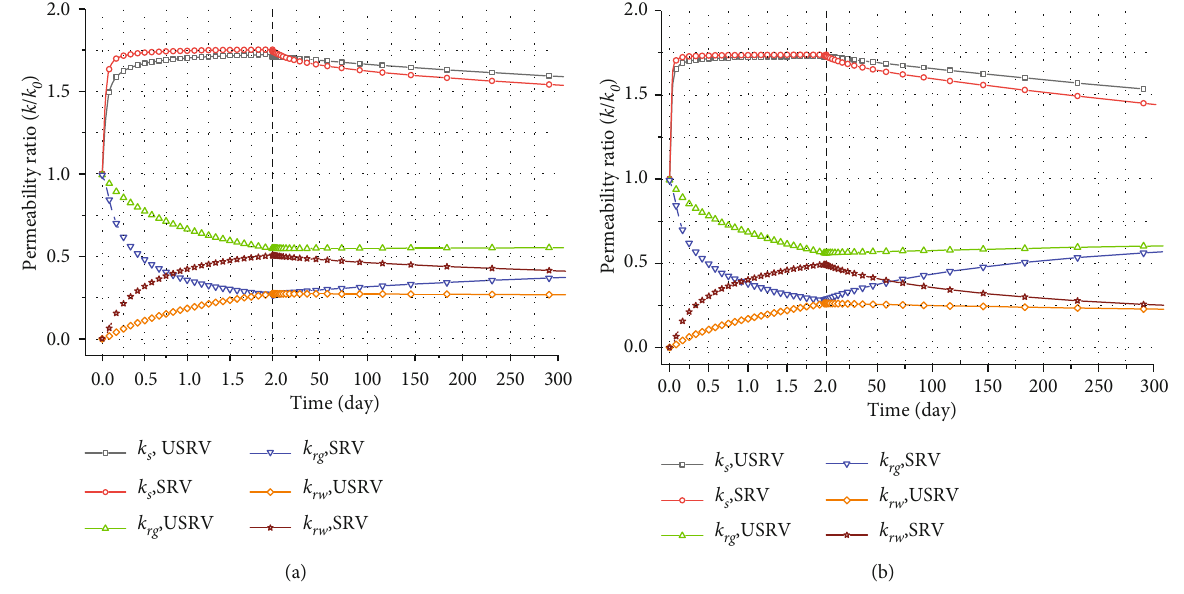
Figure 11: Gas/water relative permeability: (a) scenario B and (b) scenario